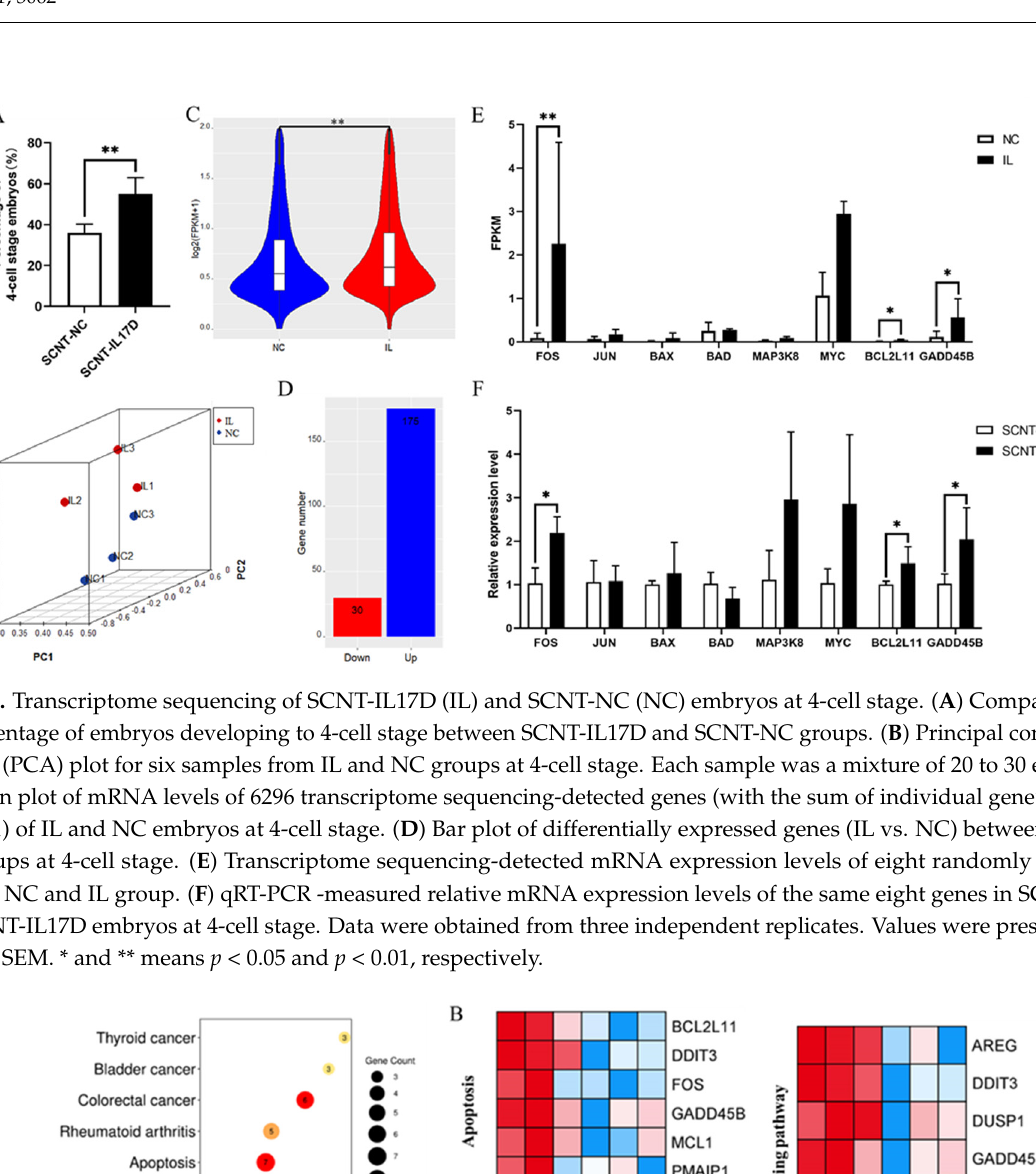
Figure 4. Analysis of transcriptome data of 4-cell stage SCNT-IL17D and SCNT-NC embryos. ( A ) Kyoto Encyclopedia of Genes and Genomes (KEGG) pathway analysis of DEGs between 4-cell stage SCNT-IL17D and SCNT-NC embryos. ( B ) Heatmap of DEGs participated in three apoptosis-related pathways.